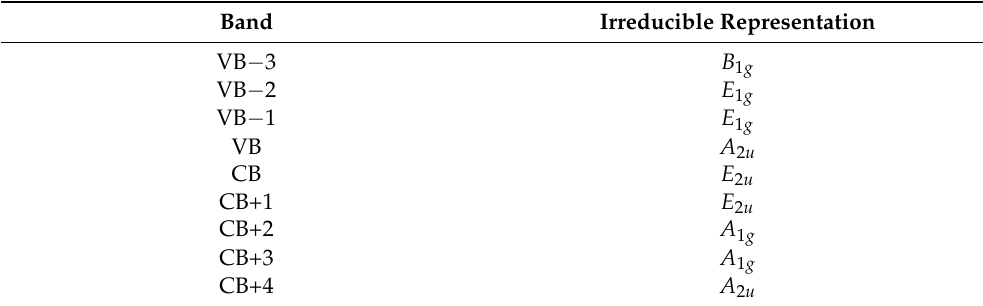
Table A2. Irreducible representations for nine bands at the Γ point. Note, that VB-1 and VB-2 are degenerate, and they are described by the partners of the two-dimensional E 1 g representation. Similarly, CB and CB+1 are degenerate, and they are described by the partners of the two-dimensional E 2 u representation.